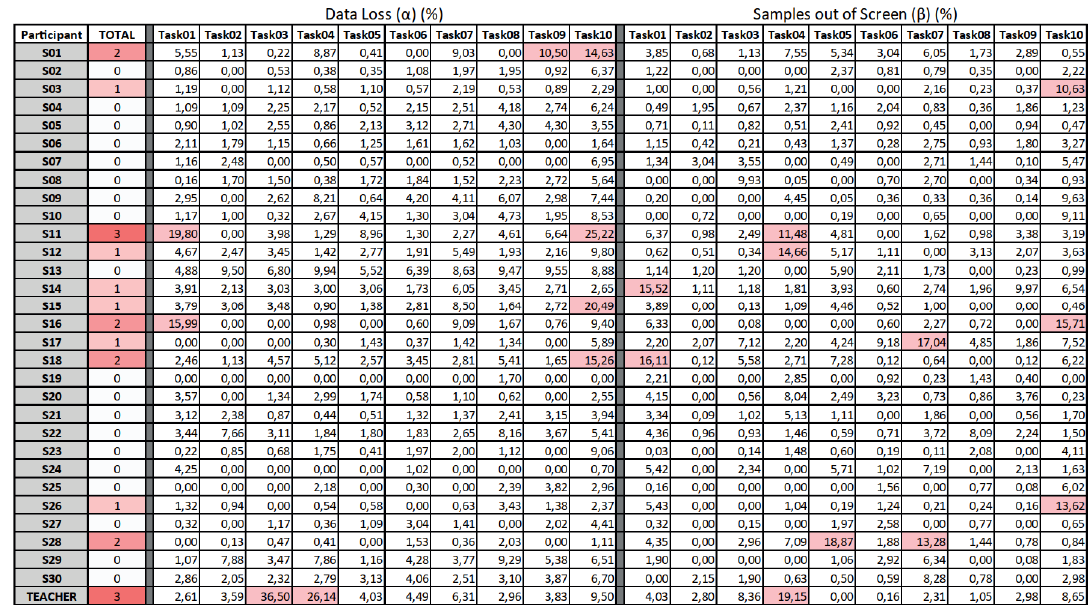
Figure 3. Overview of the data quality for 30 students and their Figure 3 . Overview of the data quality for 30 students and their teacher.